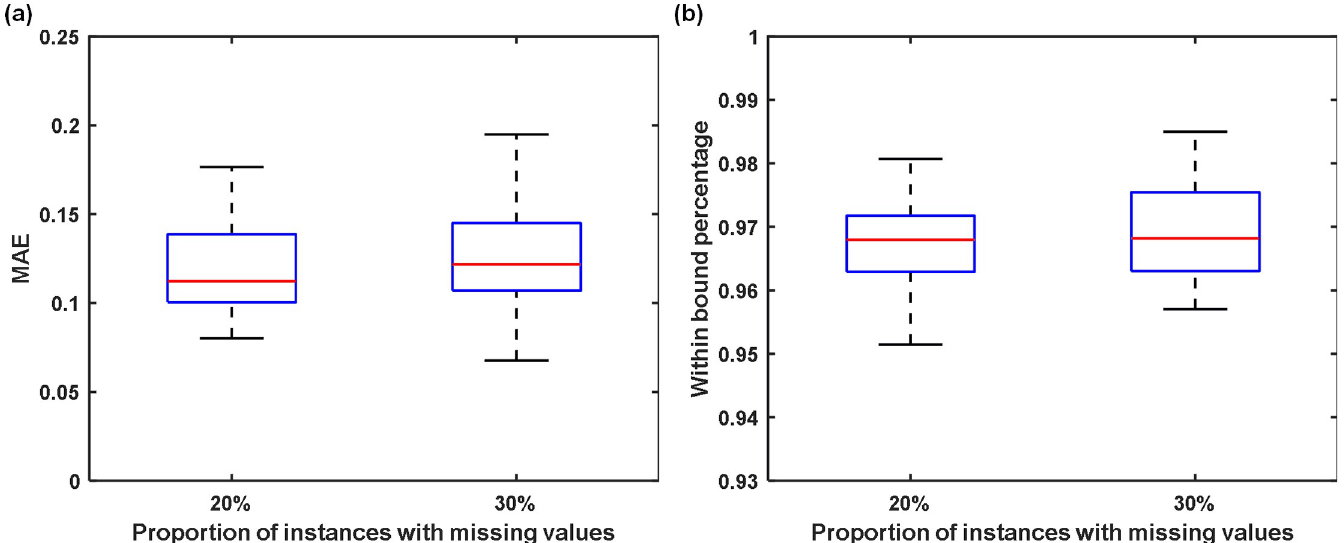
Fig 2. Imputation performance. (a) Mean absolute error (MAE) of the imputation when 20% and 30% of the instances contain missing values, and (b) proportion of true values that were contained in the imputation confidence bounds when 20% and 30% of the instances have missing values.